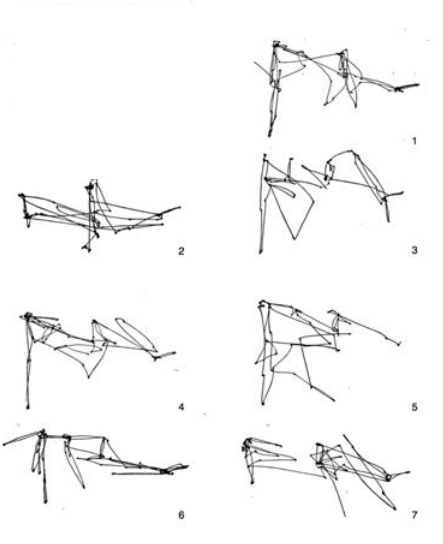
Figure 15. The figure shows recordings of 3 minutes of eye movements under free-viewing conditions, divided into 25- second segments. The order follows the numbering of pan- els. (From Yarbus 1967)